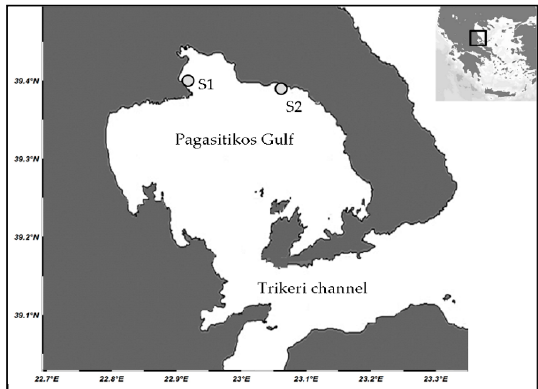
Figure 2. Map of the study area indicating the location of sampling stations (S1 and S2).